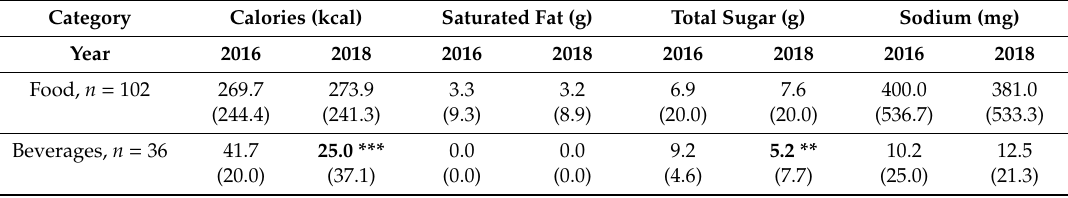
Table 1. Median (IQR) quantity per 100 g / mL of selected nutrients of concern in 2016 and 2018 1,2 .